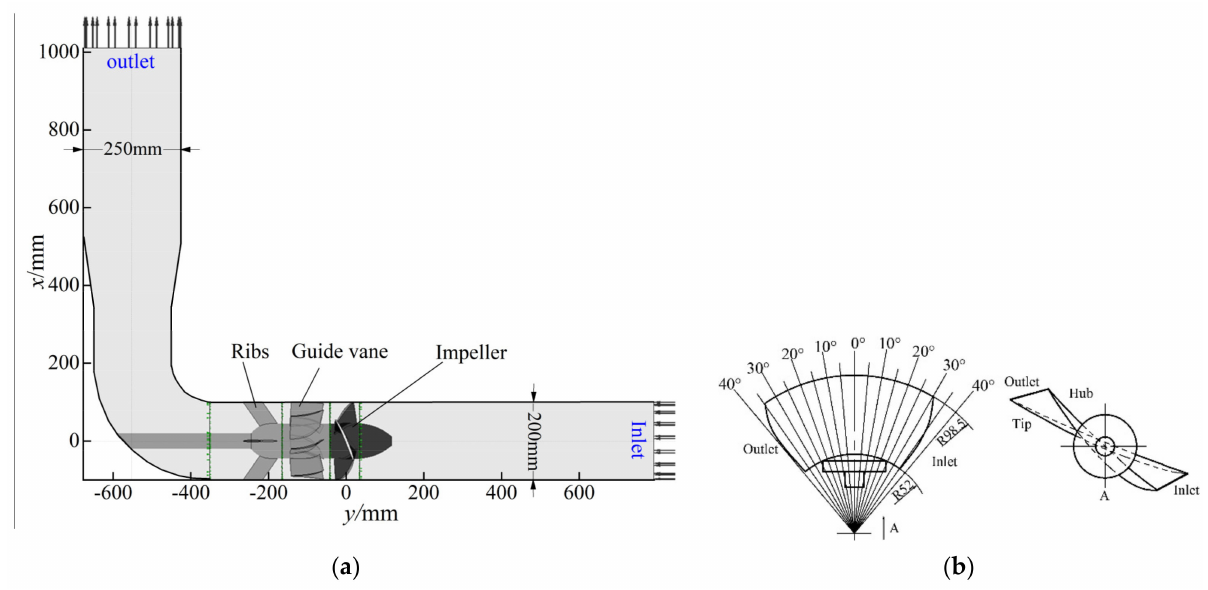
Figure 1. Axial − flow pump geometry. ( a ) Computational domain; ( b ) Impeller blade geometry.